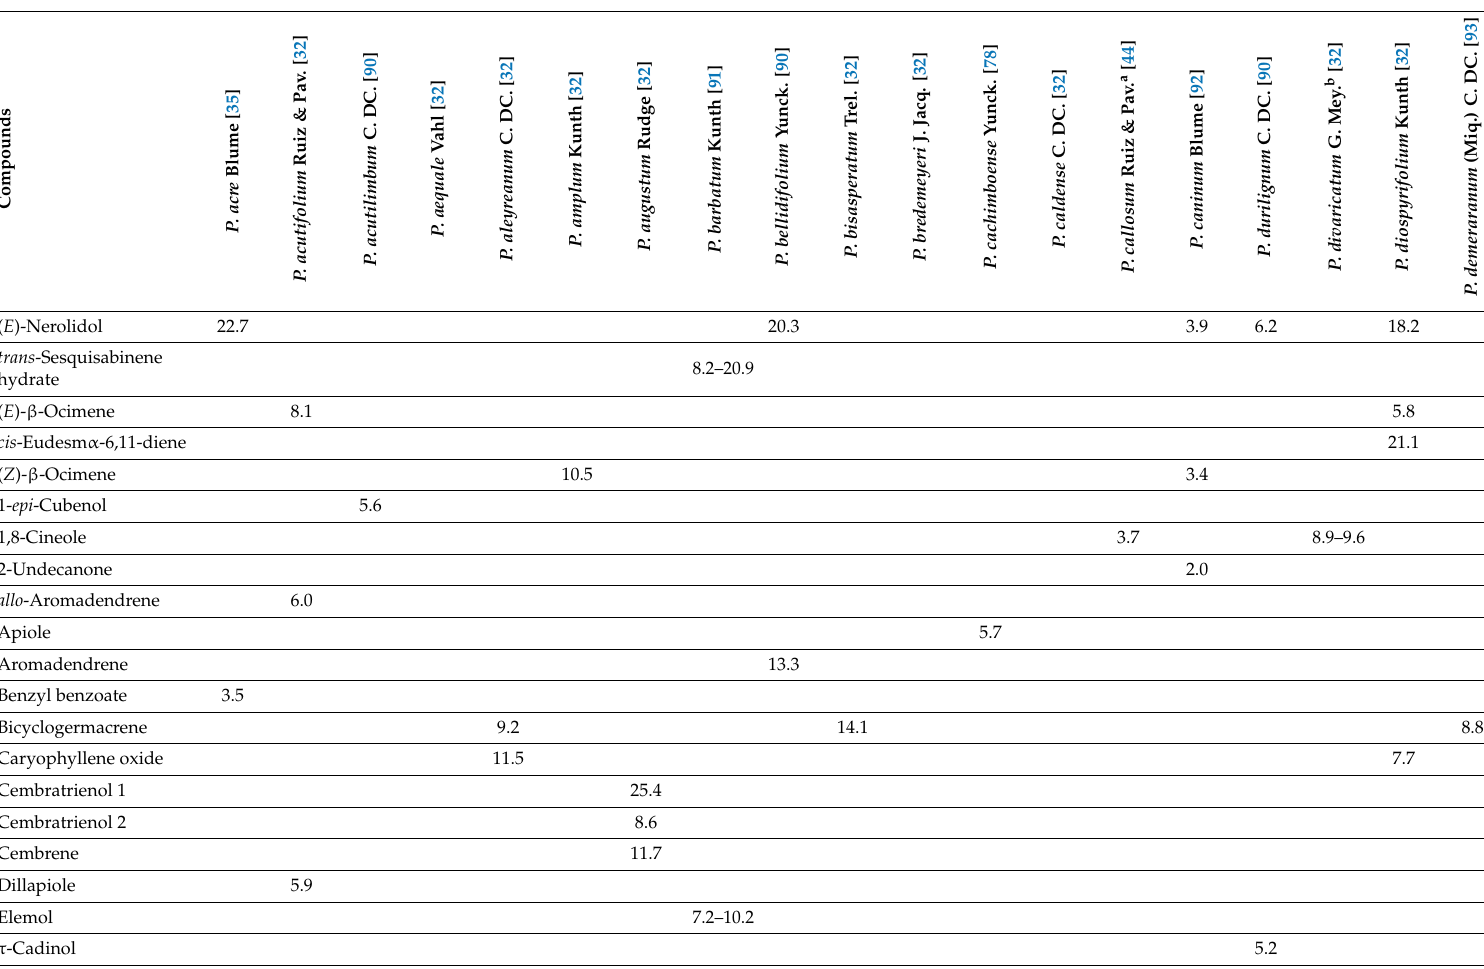
Table 22. Chemical compositions (%) of leaf essential oils from miscellaneous Piper species, part